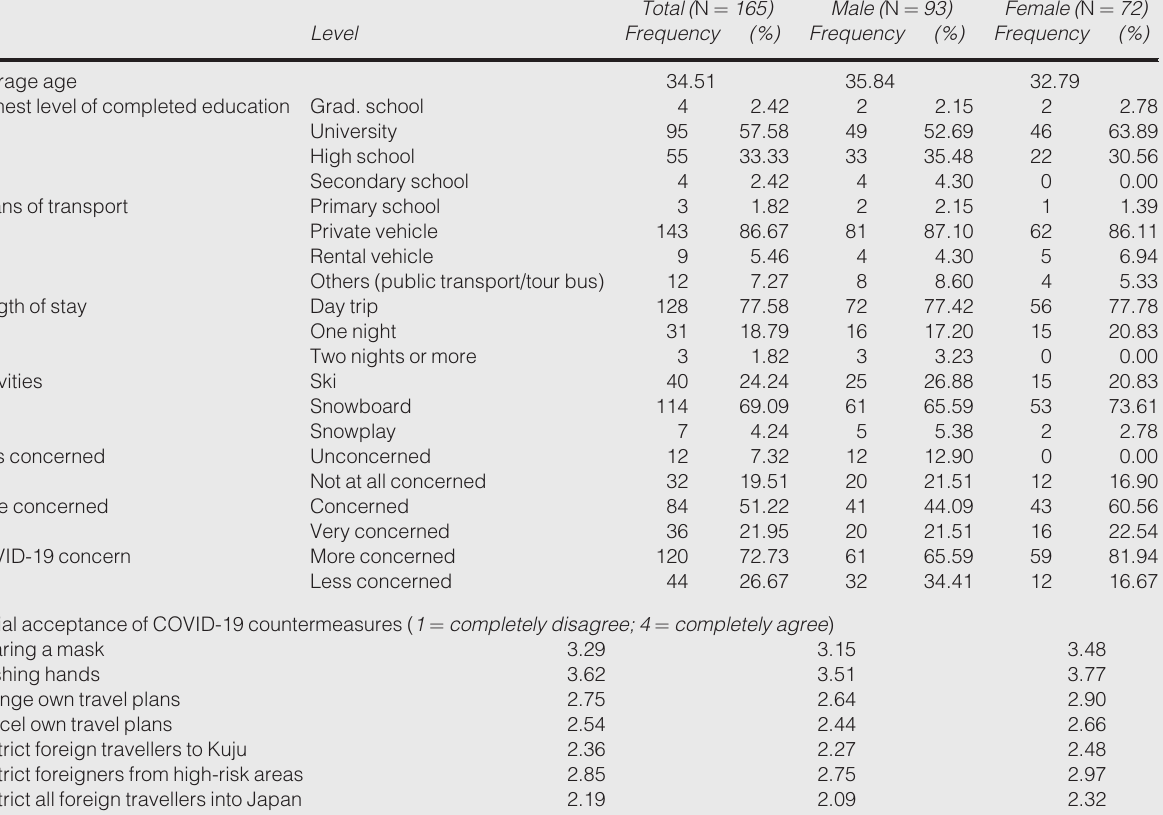
Table 1 Respondents ’ descriptive statistics by gender